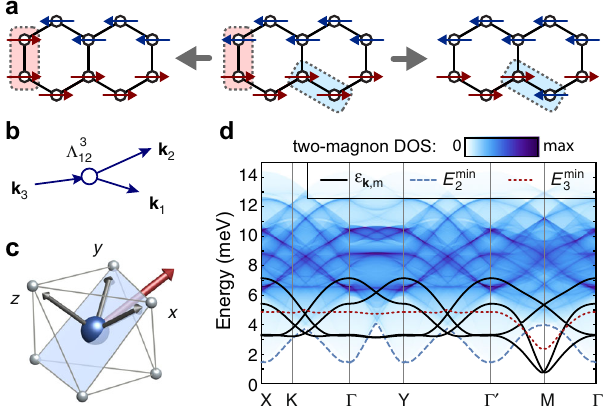
Fig. 5 Magnon decay channels for the extended model. a Local picture of additional quantum fl uctuations away from zigzag order induced by Γ 1 interactions. b Momentum space picture of the third-order decay process H J = − 0.5, K = − 5.0, Γ = 3 . c Ordered moment direction for Model 2 ( 1 1 1 +2.5, J 3 = +0.5 meV) with zigzag ordering wavevector Q = Y, parallel to the Z-bond. d LSWT dispersions ϵ k ; m , and two-magnon DOS for Model 2 with Q = Y. Dashed lines indicate the bottom of the two-magnon and three- ð k Þ and E min ð k Þ , magnon continuum ( E min 2 3